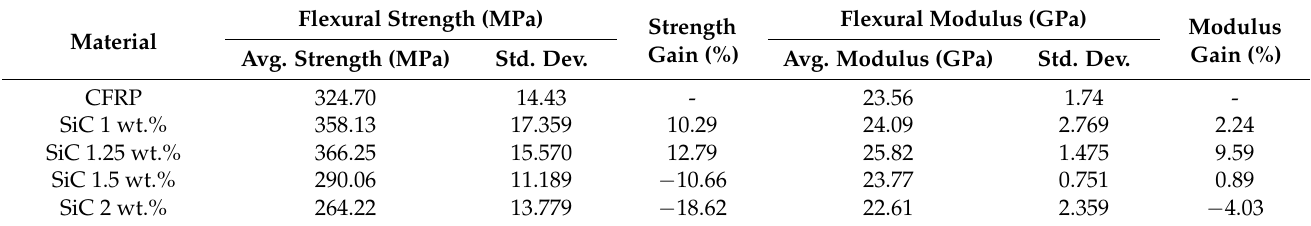
Table 7. Flexural behavior of neat and hybrid SiC nanocomposites.